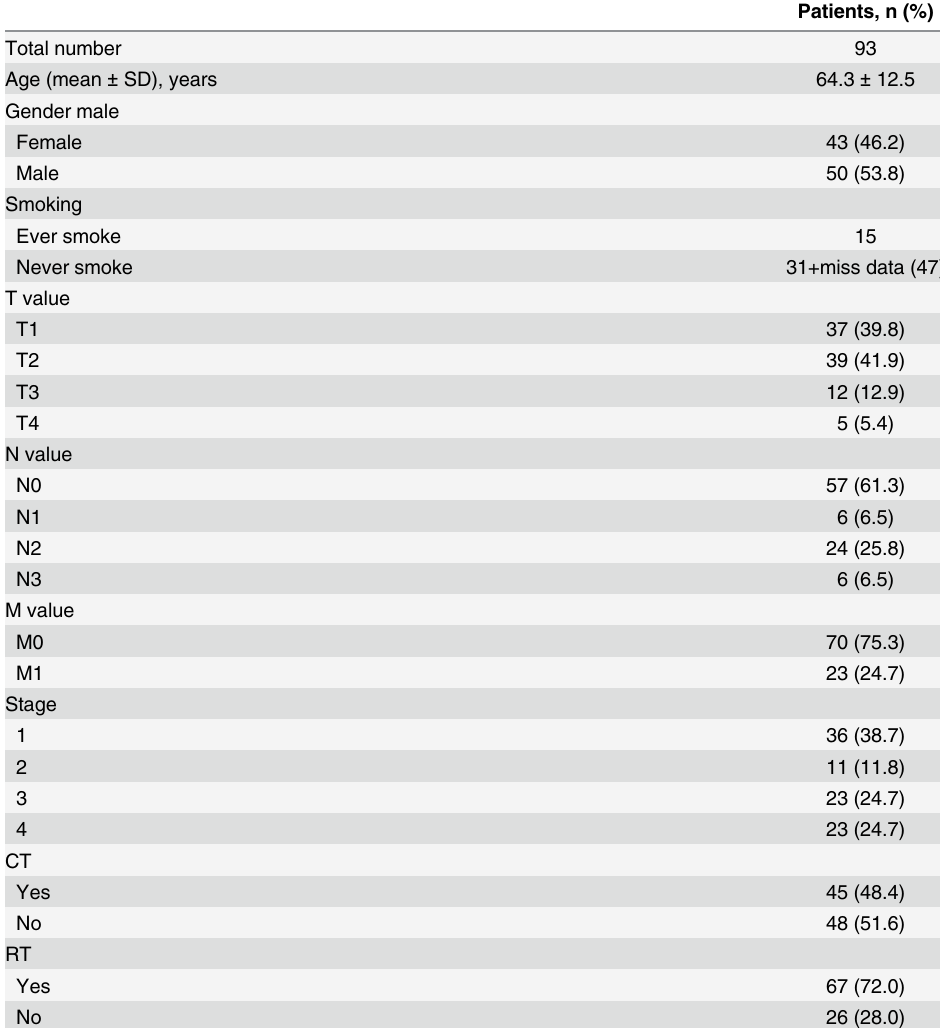
Table 1. Clinicopathological characteristics of 93 lung adenocarcinoma